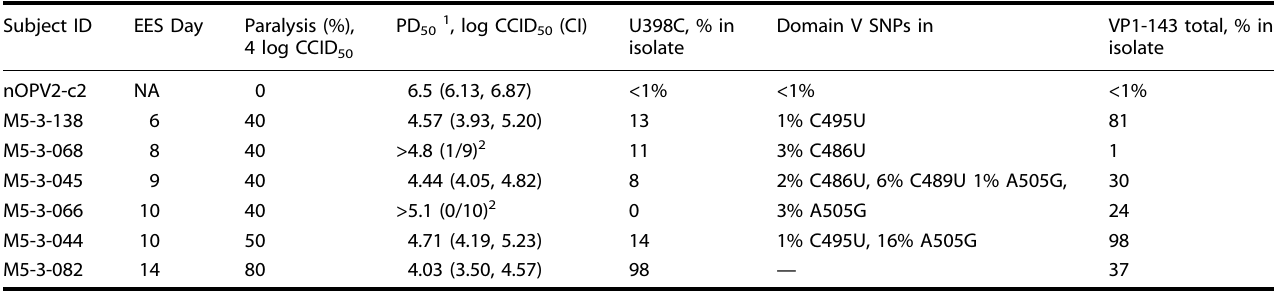
Table 2. Paralytic dose 50 (PD50) and key polymorphisms in culture-ampli fi ed shed nOPV2-c2 virus with higher virulence.